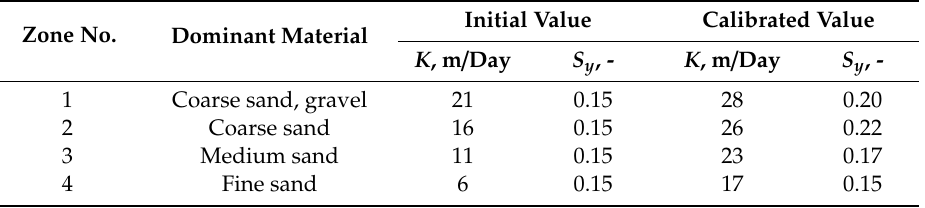
Table 1. Initial and calibrated values of the hydraulic conductivity ( K ) and specific yield ( S y ) of the aquifer. Zone No.